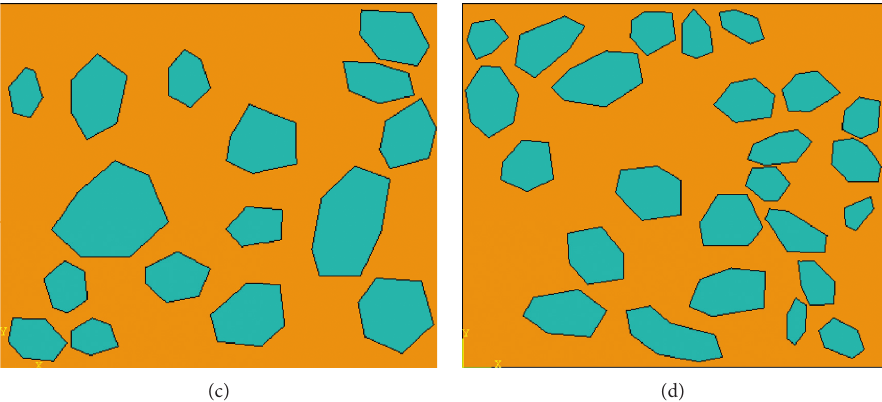
Figure 11: Simulation model of the uniaxial compression test with polygonal pores: (a) simulation model 1, (b) simulation model 2, (c) simulation model 3, and (d) simulation model 4.